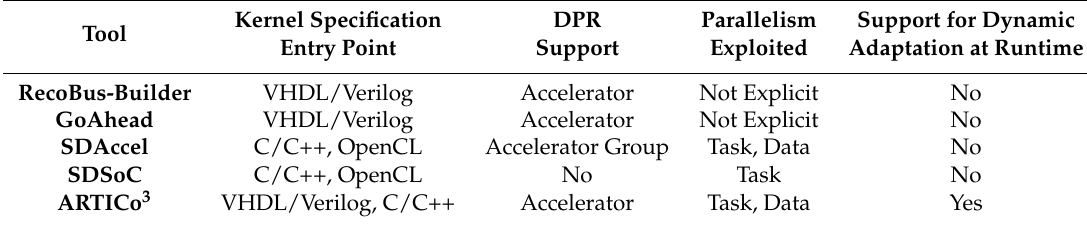
Table 1. Design tools